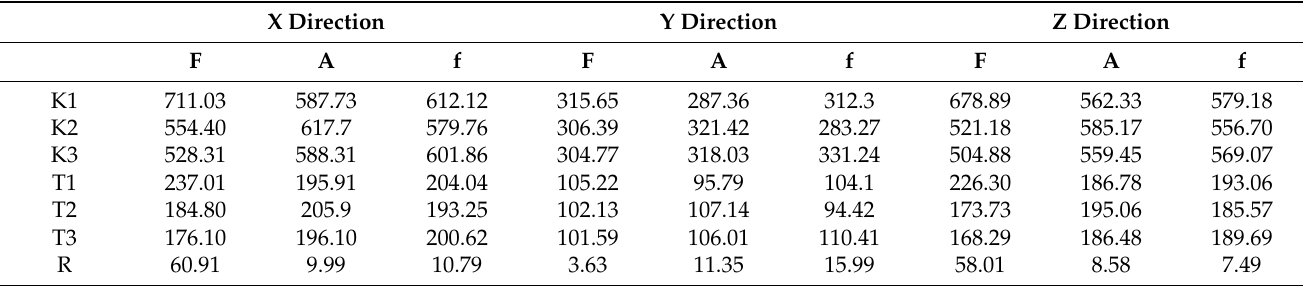
Table 2. Range of residual